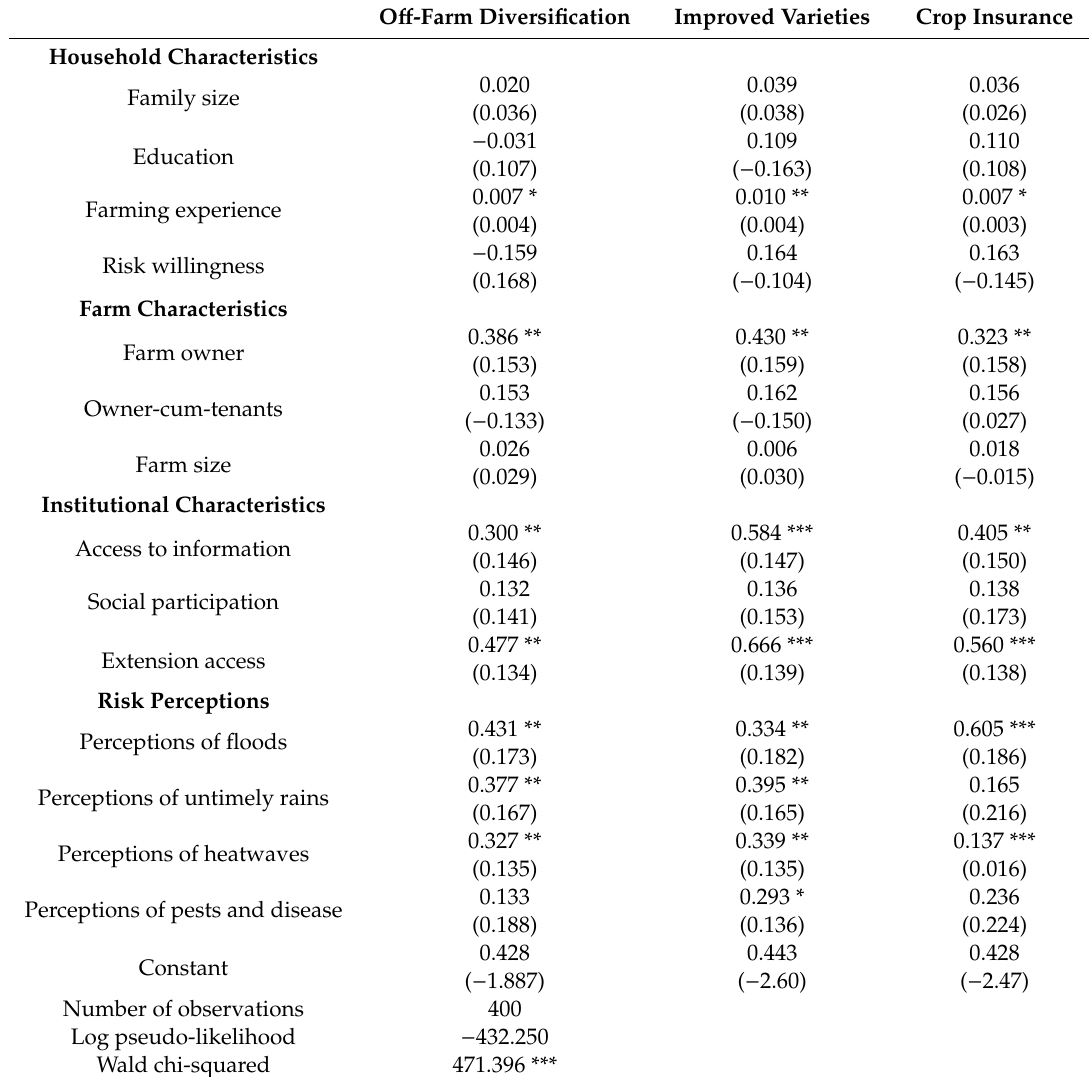
Table 2. Multivariate probit (MVP) model for estimating determinants of adoption of risk management tools.